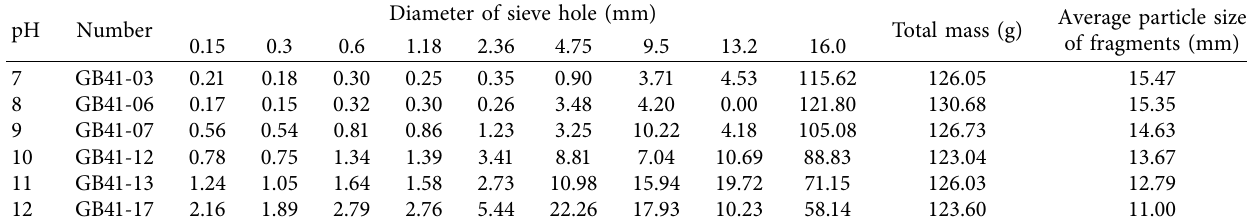
Table 2: Sieving results of sandstone specimens in broken pieces.